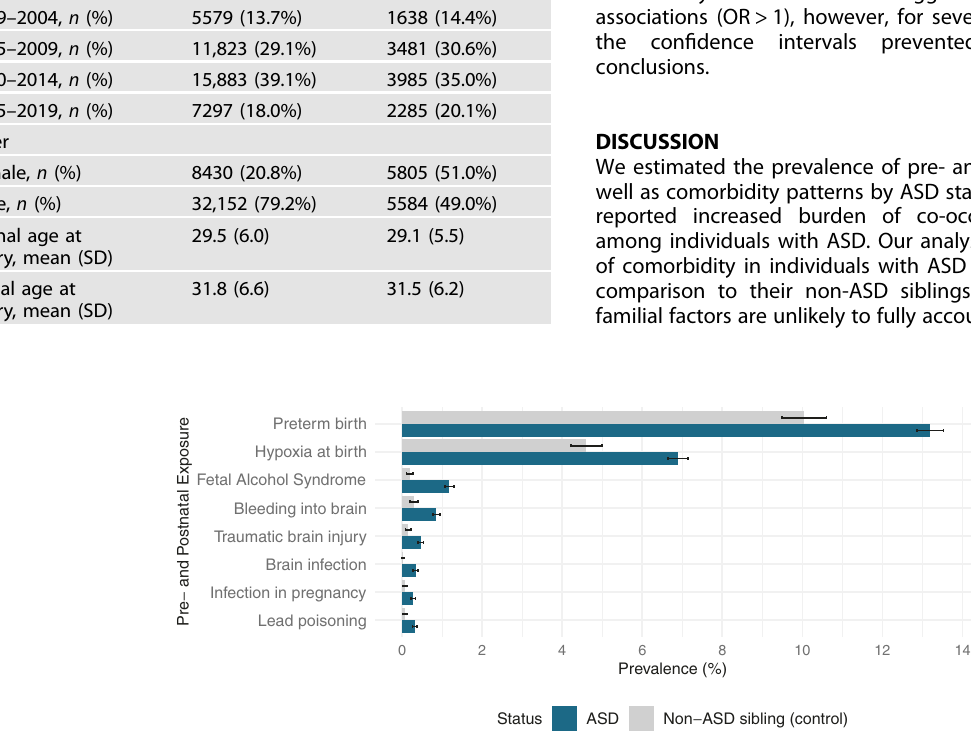
Fig. 1 Barplots illustrating the prevalence (%) of pre- and postnatal exposures by ASD status. Prevalence estimates in unaffected siblings (grey bars) were standardized to year of evaluation, age and sex distribution in ASD cases (blue